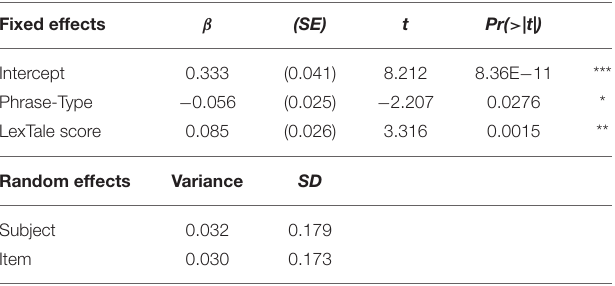
TABLE 5 | L2 translation accuracy LMER